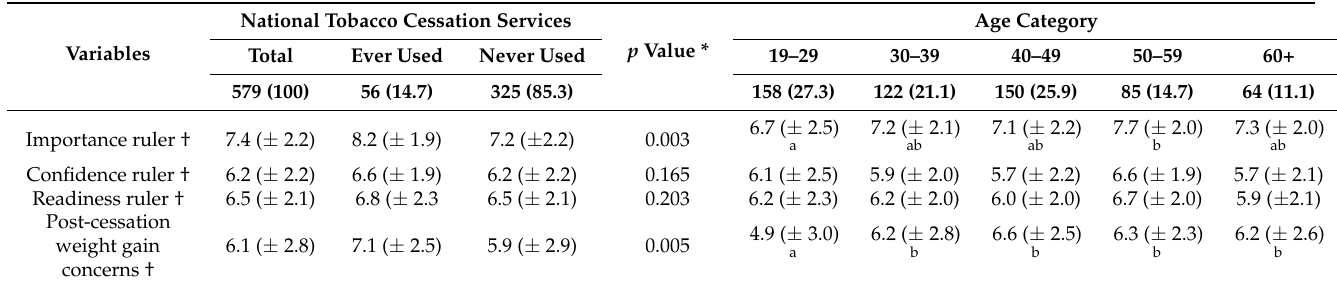
Table 4. The survey participants’ motivation ruler for smoking cessation and concern about weight gain ( n = 579).